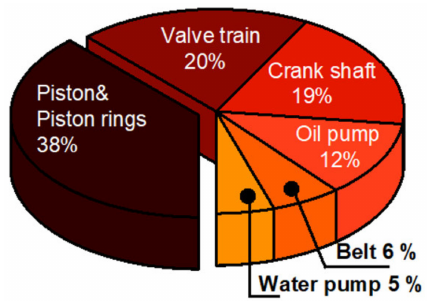
Figure 3. Breakdown of mechanical friction loss